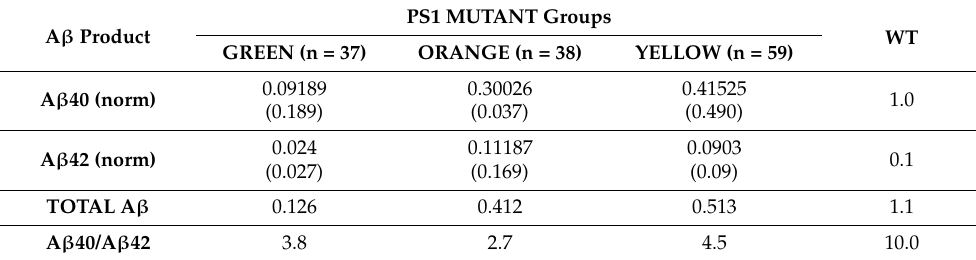
Figure 4. FAD-PS1 and motions of PS1 during APP proteolysis. ( A , B ) PS1 sequence ( A ) and structure ( B ) are color-coded for FAD-PS1 mutation groups defined in Table 1. GD is green domain, YD is yellow domain, and OD is orange domain. ( C , D ) The predicted motion (white arrows) of the green domain during APP cleavage — side view ( C ) and ECM view ( D ). The APP entry into active site of γ -secretase is shown by blue arrow on panel. ( D – F ) The predicted motion (white arrows) of orange domain during APP cleavage — ECM view ( E ) and cytosolic view. ( F , G ) The predicted motion (white arrows) of the yellow domain ( C H6-YD) and APP (Blue) during APP cleavage is shown (side view). The cleavage site at VI residues of APP is shown in pink. Table 1. A β peptide generation by FAD-PS1 mutants. Based on the published reports [25,26] we identified 3 groups of PS1-FAD mutations—“green”, “orange” and “yellow”. For each group the levels of A β 40 and A β 42 produced PS1-FAD mutants were normalized to the levels produced by wild type PS1. The normalized values were averaged within each group and shown as mean (S.E., n = 37, 38, and 59 as indicated for each group). The total levels of A β for each group and wild type were calculated by adding average A β 40 and A β 42 values. An average A β 40/A β 42 ratio for each group and wile type was calculated by dividing mean A β 40 to mean A β 42